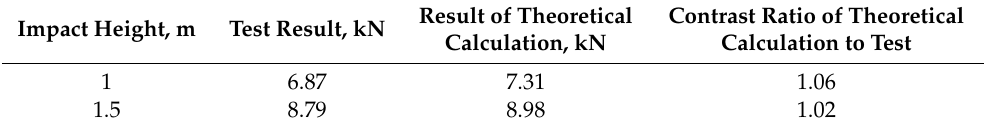
Table 4. Data results comparison of the maximum impact force between test and theoretical calculation. Result of Impact Height, m Test Result, kN